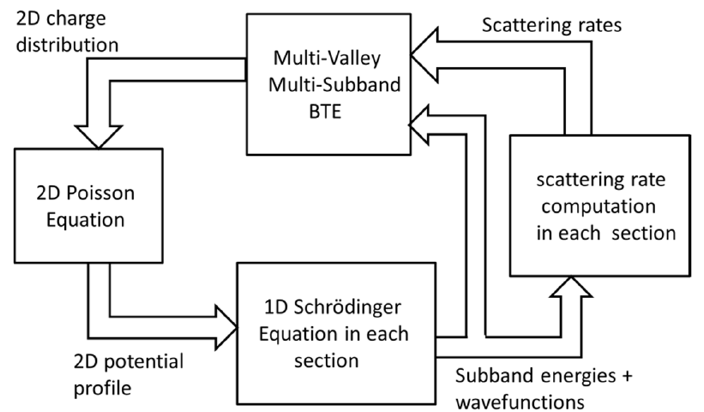
Figure 2. Simplified flowchart of the multi-valley/multi-subband Monte Carlo method in the spatially two-dimensional implementation used in this work.